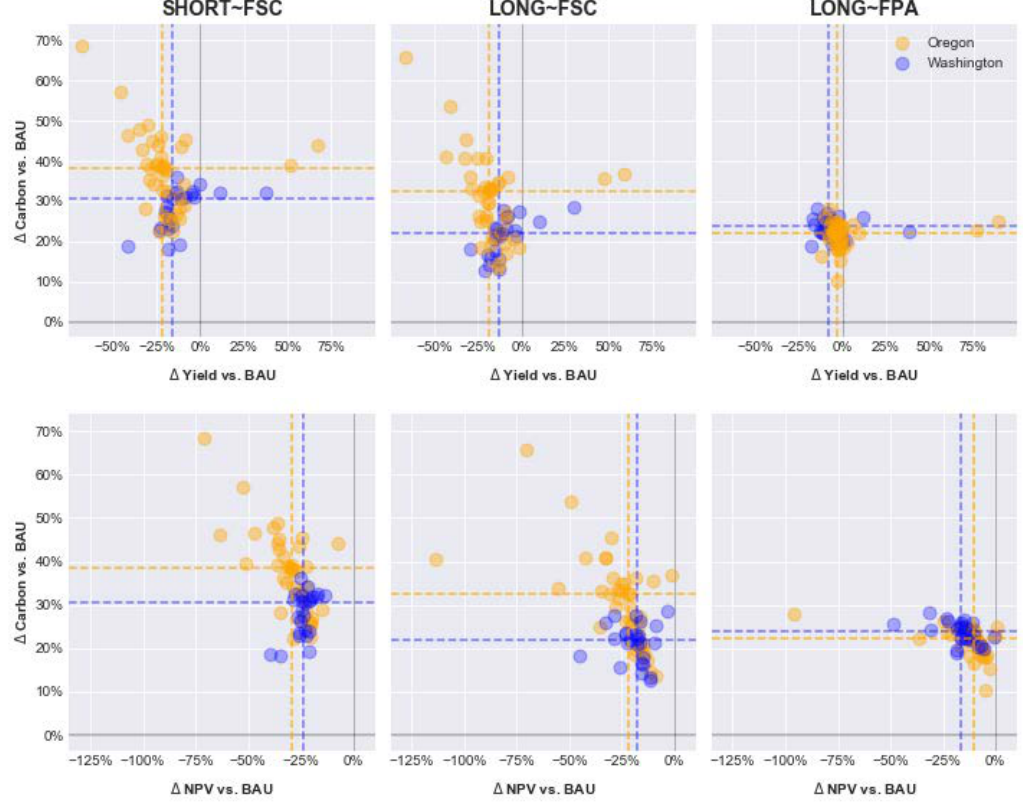
Figure 7. Shifts in timber yield, carbon storage, and cash flow relative to business-as-usual (NPV~FPA) for each of the three alternative scenarios. The top row of graphs shows carbon and timber yield shifts; the second row shows carbon and cash flow shifts. Each point corresponds to one of the 64 simulated parcels. The dashed lines represent the median value.